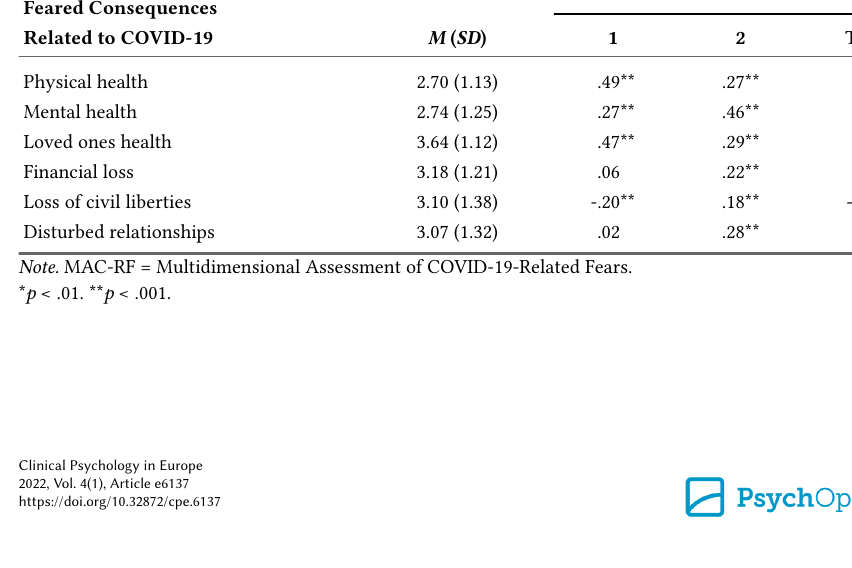
Correlations Between the MAC-RF and Fear of Different Types of Consequences Related to COVID-19